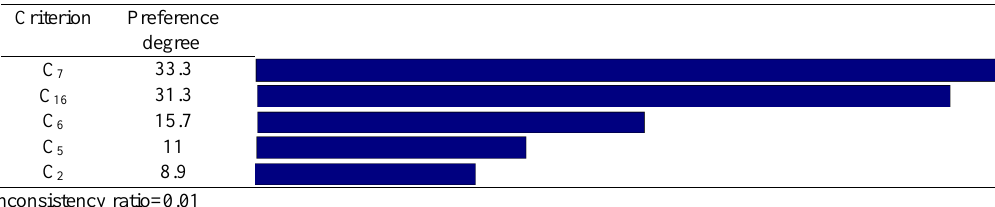
Table 11. Comparison of proposed criterion importance to access the goal.